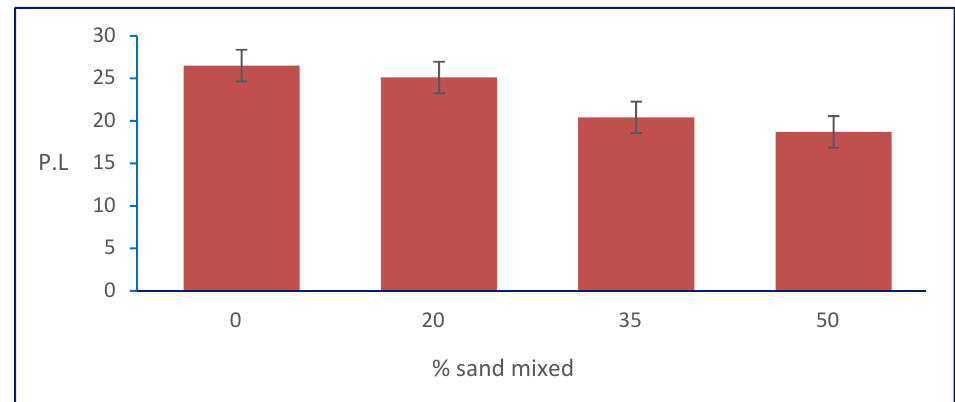
Figure 10. Effect of sand on PL.